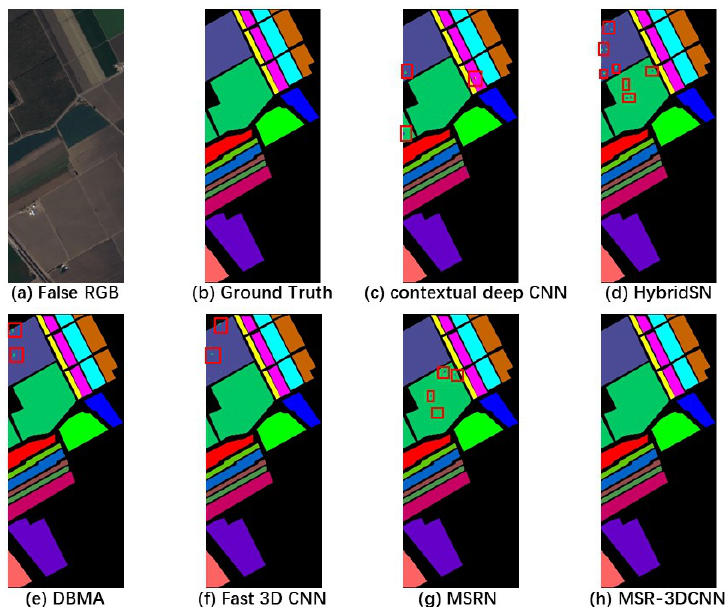
Figure 12. Results of the SA dataset using 10% samples for training and ( 9 × 9 ) patch